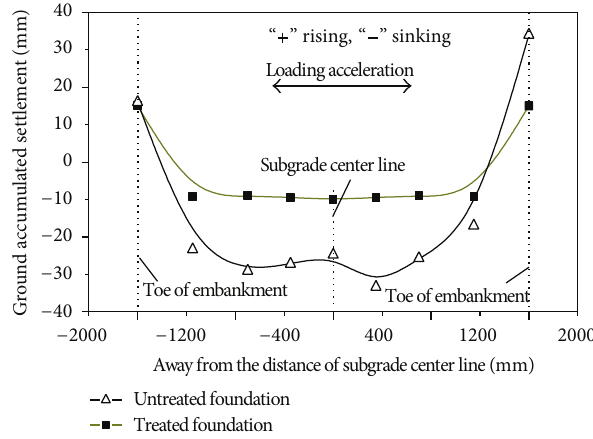
Figure 12: The accumulated settlement distribution of ground surface along subgrade transverse section